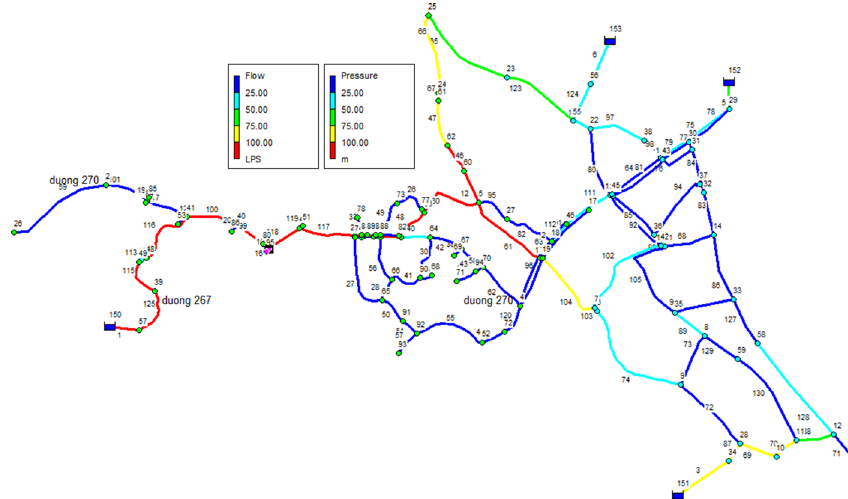
Fig. 11 Water distribution